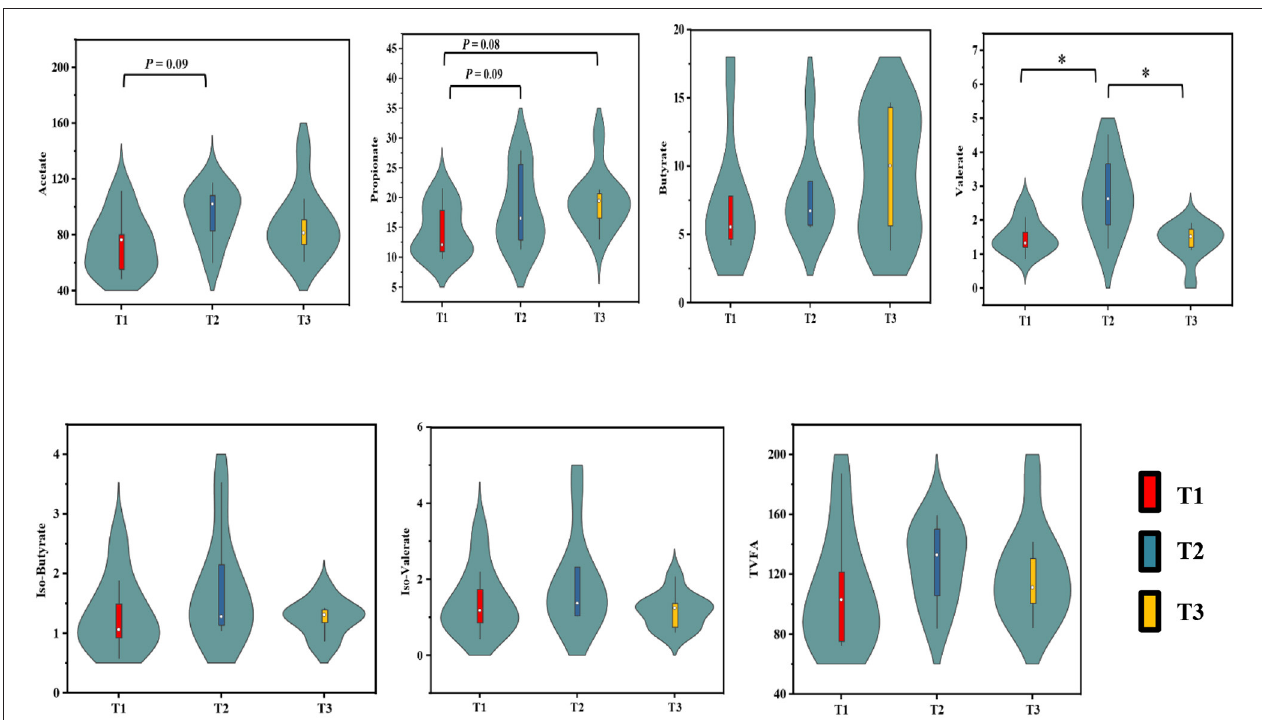
FIGURE 1 | Effects of dietary amylose/amylopectin ratio on cecal SCFAs concentrations ( µ mol/g). On each side of the gray line is a kernel density estimation to illustrate the distribution of shape of the data in a group. Wider and skinnier sections of the violin plot represent a higher and lower probability that members of the samples will take on the given value. The white dot represents the median and the thick gray bar in the center represents the interquartile range. *Significantly different means ( P < 0.05). T1 (normal corn 100%, high amylose corn 0%); T2 (normal corn 50%, high amylose corn 50%); T3 (normal corn 0%, high amylose corn